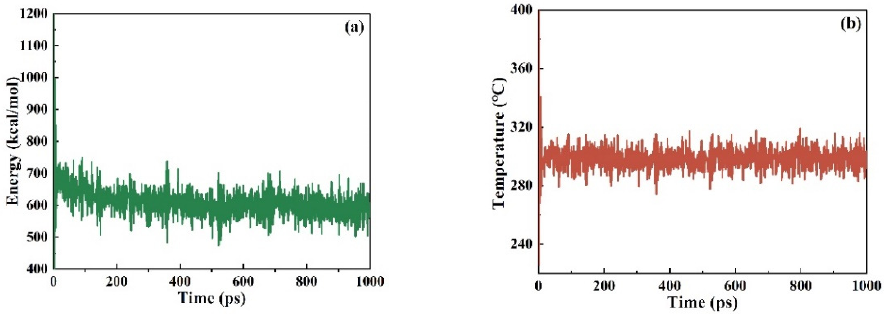
Figure 2. Energy and temperature variation of the model: ( a ) Energy–Time; ( b ) Temperature–Time. The temperature–time variation of the water–cellulose composite model is shown in